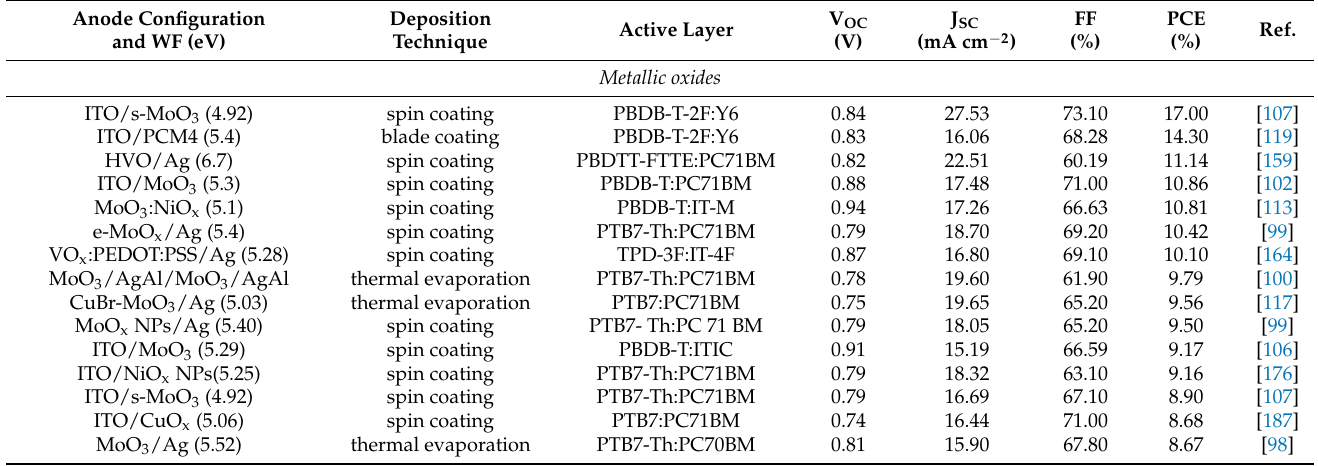
Table 1. Performance parameters of OSCs with inorganic films as